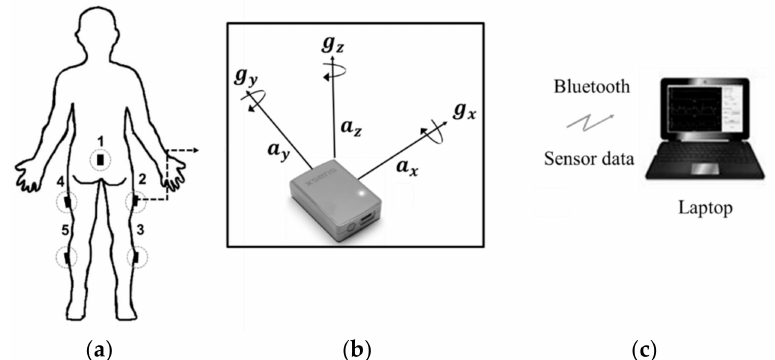
Figure 1. ( a ) Inertial measurement unit (IMU) placement: (1) lumbar region, (2) right thigh, (3) right calf, (4) left thigh, and (5) left calf; ( b ) definitions of axes used by IMUs; and ( c ) laptop used for data